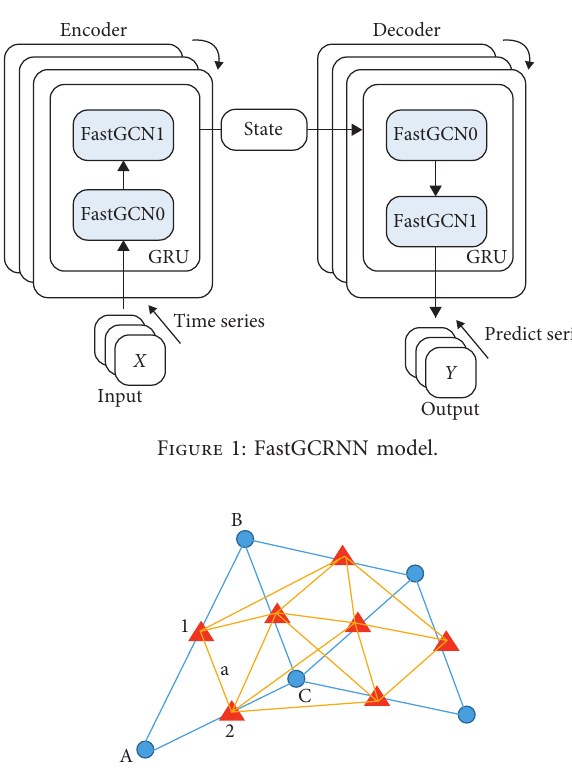
Figure 2: Construction process of road network edges, as illustrated through the red triangles and yellow lines in Figure 2, respectively.